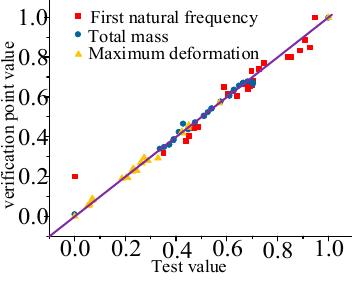
Figure 30. Normalized curve.